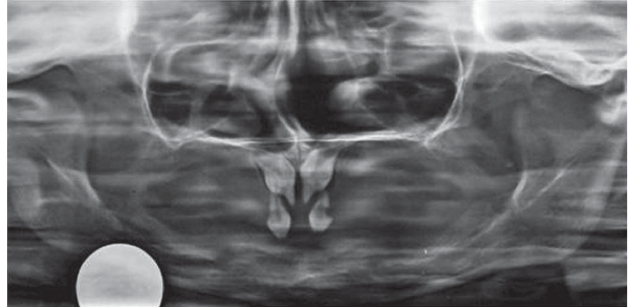
Fig. 3 : Digital panoramic radiograph showing multiple agenesis of permanent teeth and malformed unerupted conical maxillary incisors Impression trays were specially designed and fabricated using an aluminum wire stabilized with green wax (Figure 4) and impressions were made using putty and light viscosity